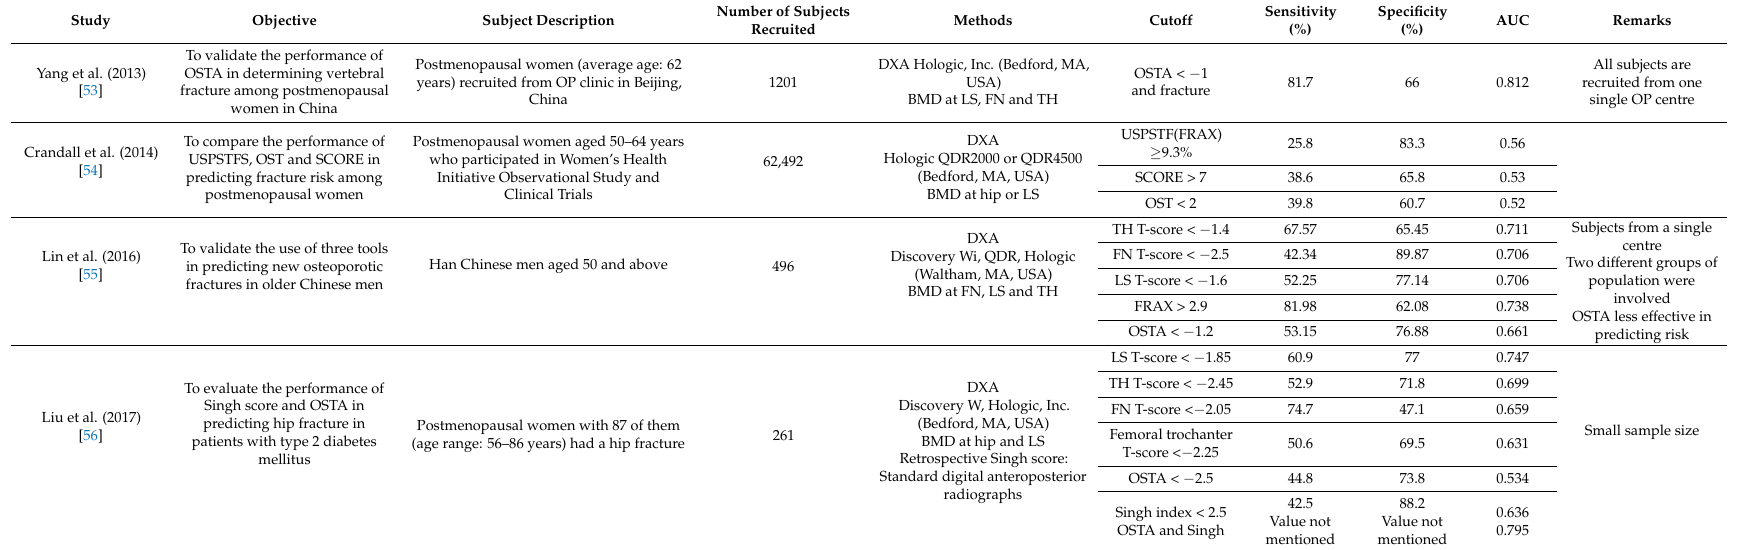
Table 3. Performance of OST to predict fracture